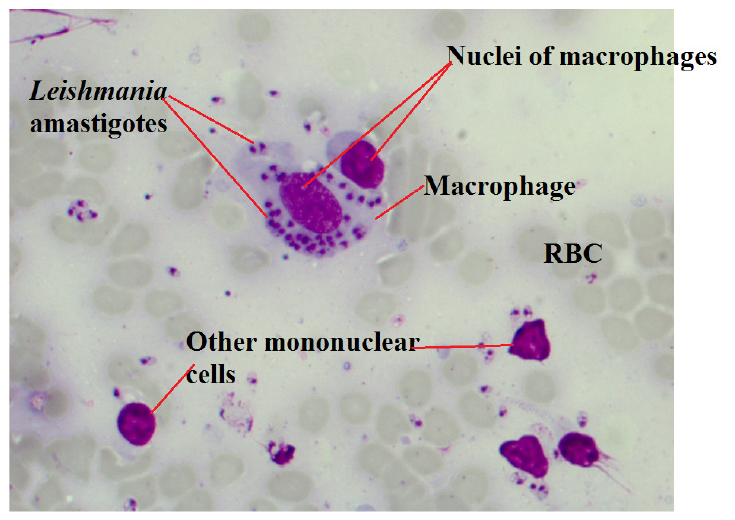
Figure 2: Leishmania amastigotes present in slit- skin smear of CL positive patients (1X400).